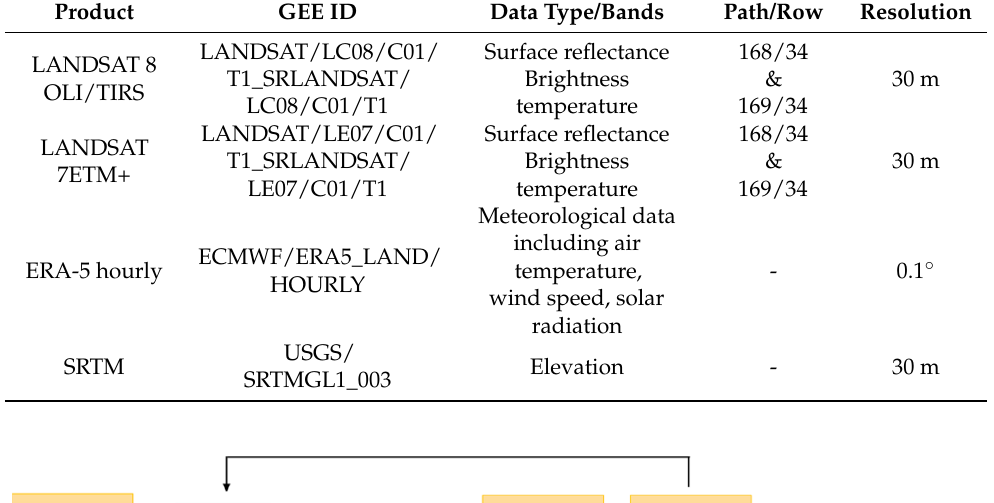
Table 2. Data used in this study and their characteristics from GEE.